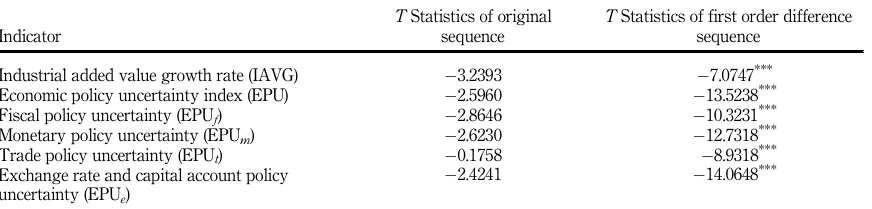
Table 1. Unit root